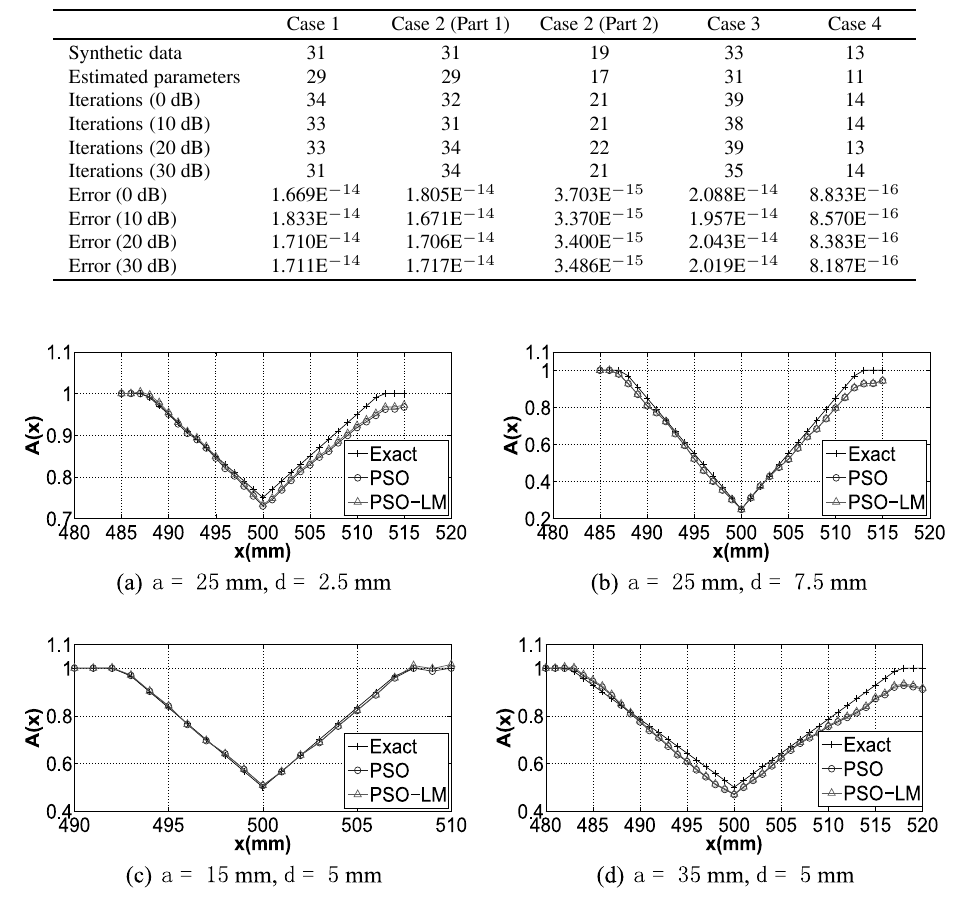
Fig. 11. Damage identi fi cation for different values of a and d , Case 1, SNR = 0 dB.